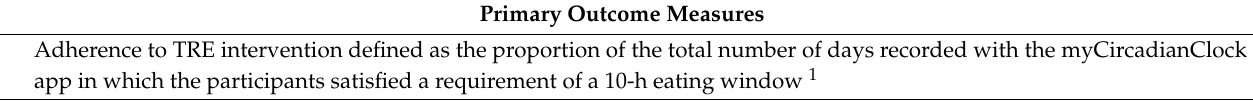
Table 2. Outcome